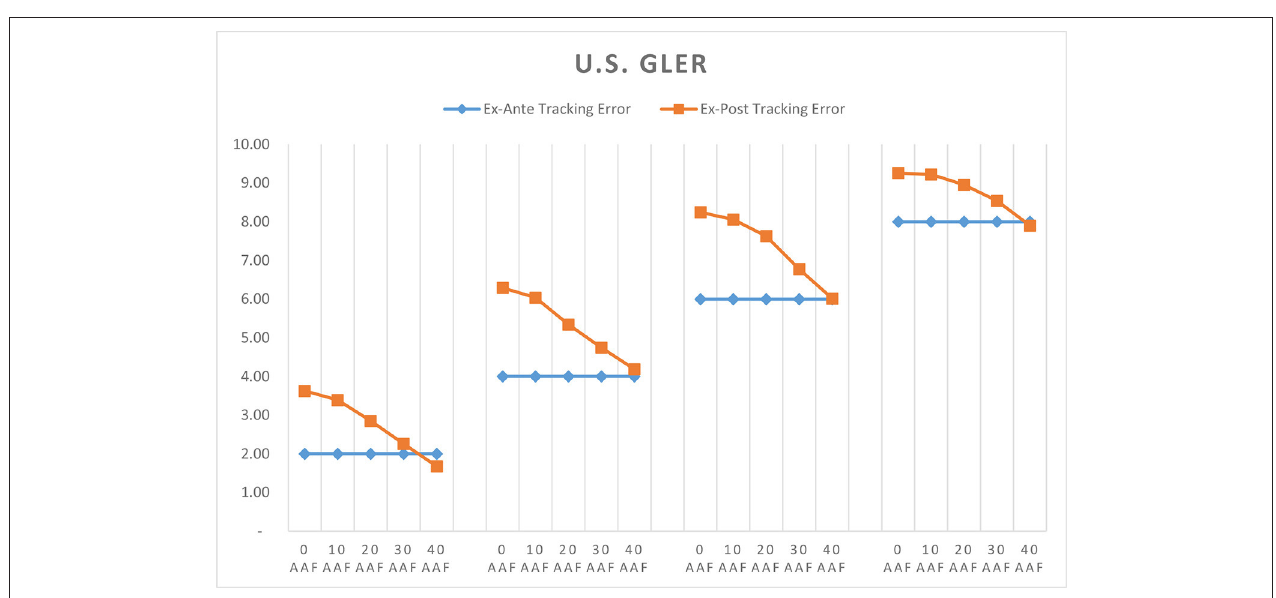
FIGURE 9 | U.S. GLER ex-ante vs. ex-post tracking